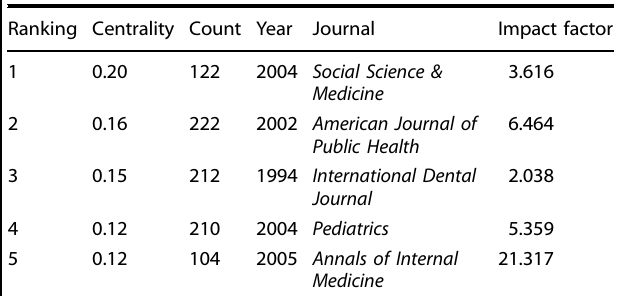
Table 4. Top 5 co-cited journals according to